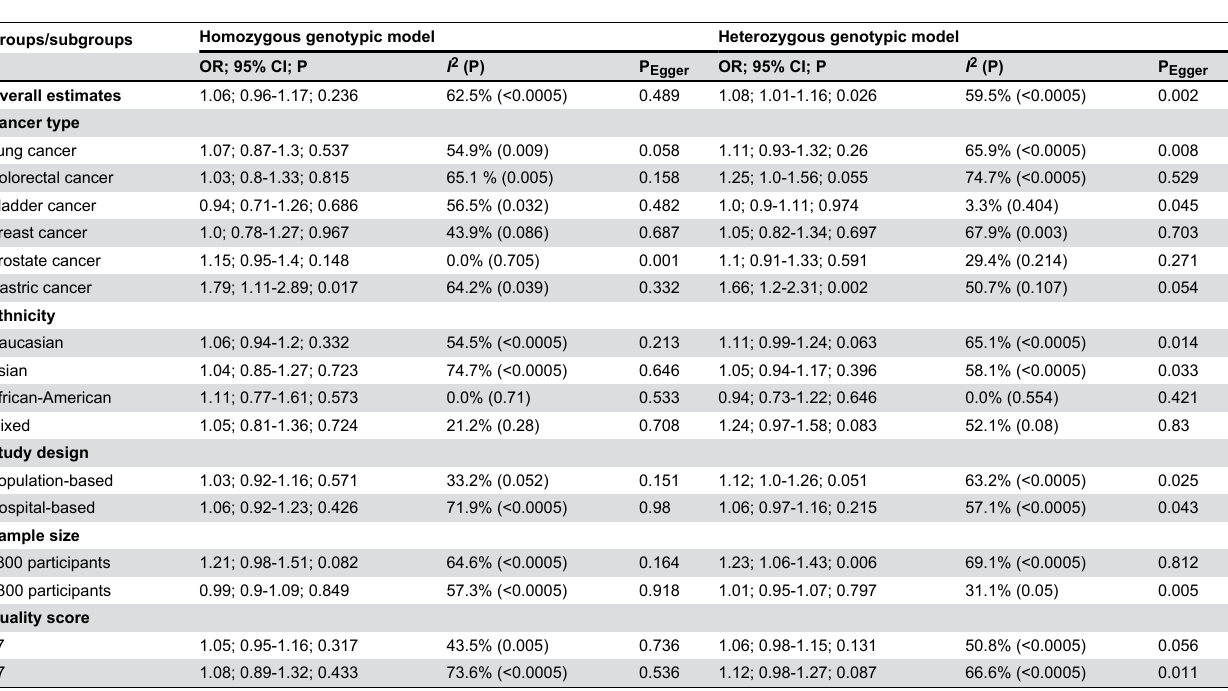
Table 3. Overall and subgroup estimates of the associations of APEX1 Asp148Glu polymorphism with cancer risk under two genotypic